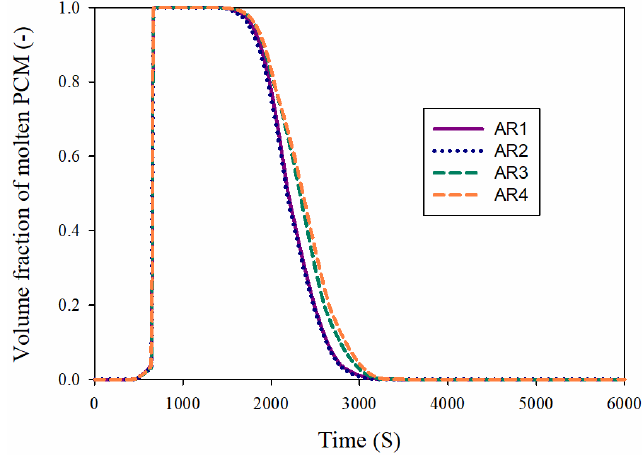
Figure 11. Volume fraction of molten PCM around the BTPC for different values of cavity AR up to 6000 s.